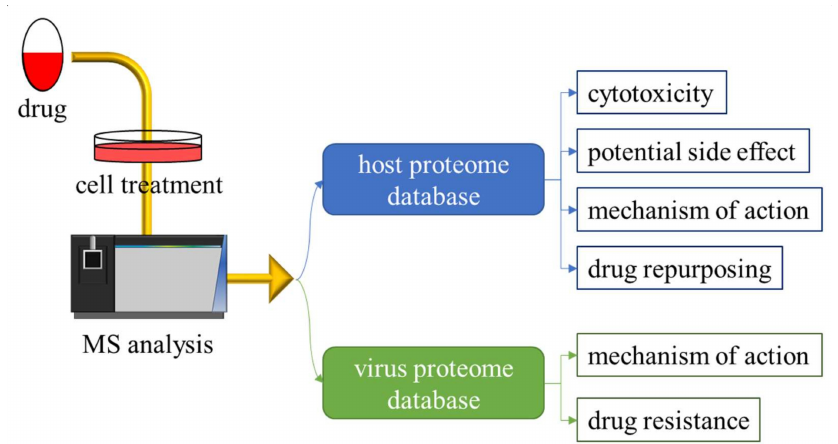
Figure 6. Identify drug-targeted proteins from both host and virus proteome databases. In high- throughput proteomic analysis, a large amount of information was produced in a single experiment. The results of the modification site and pathway induction/reduction were integrated from the MS analysis when the cells were treated with drugs with covalent or noncovalent interactions with drug- targeted proteins. After treatment with covalent drugs, information on drug-related proteins was analyzed with MS-based proteomics against both host and virus proteome databases to determine the mechanism of action of the drug and its potential limitations such as cytotoxicity or other side